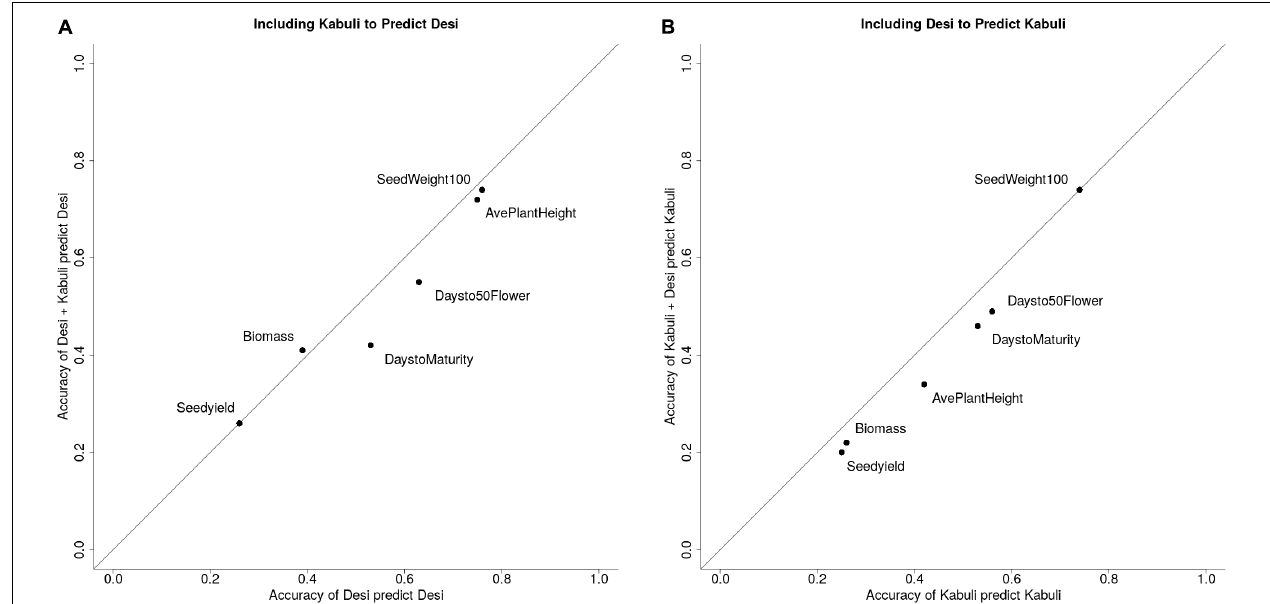
FIGURE 3 | Prediction accuracies for Desi and Kabuli with different structures for training and validation sets. (A) Prediction accuracy of using only Kabuli lines to predict Kabuli lines vs. using both Desi and Kabuli lines to predict Kabuli lines. (B) Prediction accuracy of using only Desi lines to predict Desi lines vs. using both Kabuli and Desi lines to predict Desi